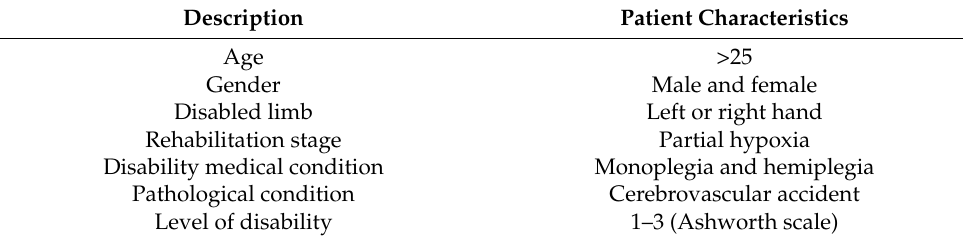
Table 2. Profile of the participants for the conducted clinical